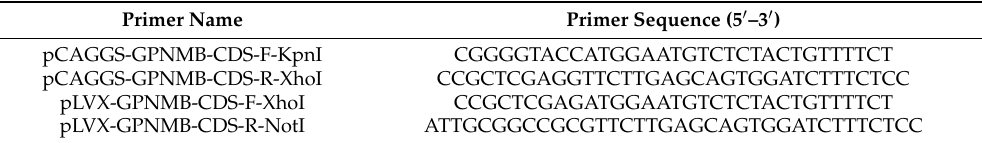
Table 2. Primers used for plasmid construction.